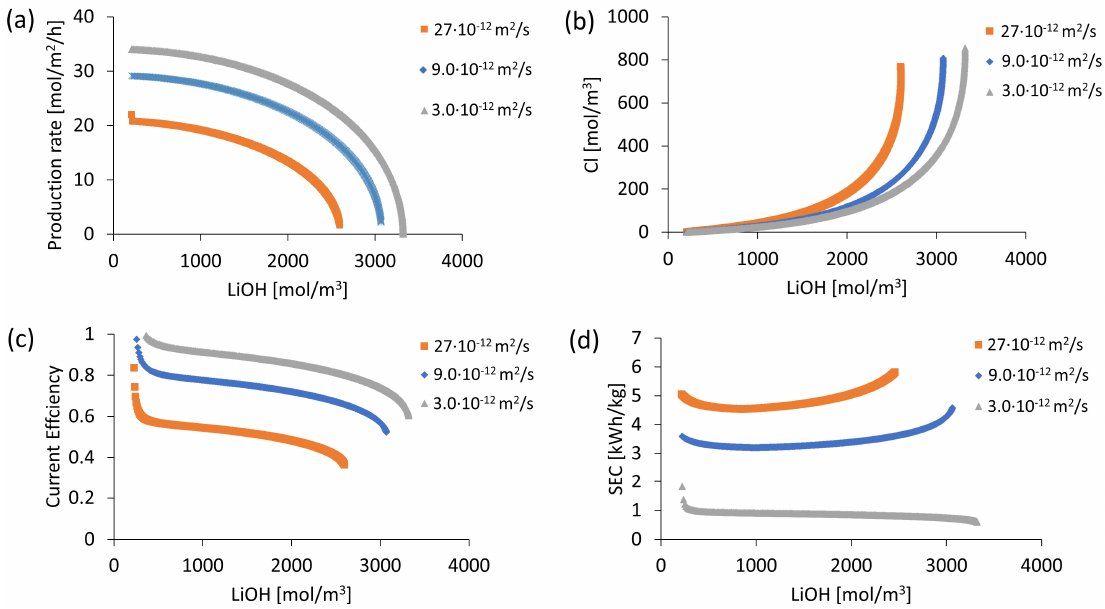
Figure 3. Simulation results according to different degrees of OH − leakage: ( a ) LiOH production rate; ( b ) Cl − concentration; ( c ) Current efficiency; ( d ) Specific electricity consumption (SEC).